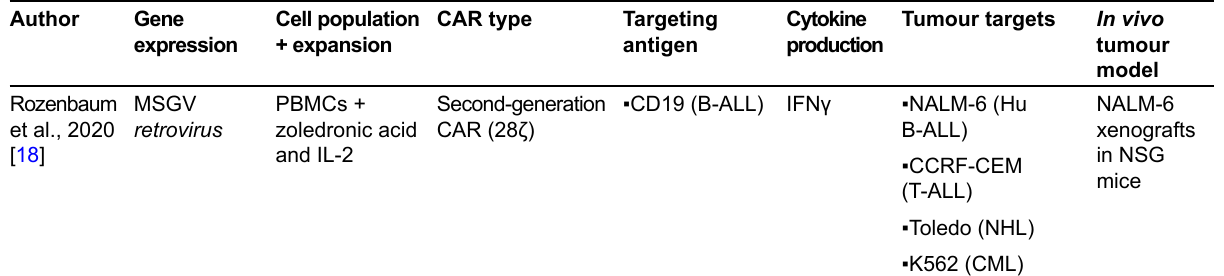
Table 1 . Summary of published studies related to CAR expression in γδ T cells ( continued